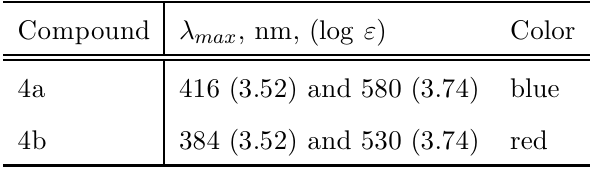
Table 3 Visible absorption spectra of the anions of compounds 4a,b* *In DMSO + KOH (the molar ratio compound : KOH =1 :